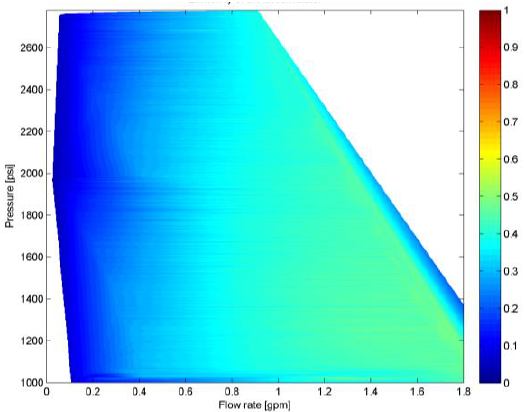
Figure 16. Instantaneous efficiency for conversion of electric power to hydraulic power.